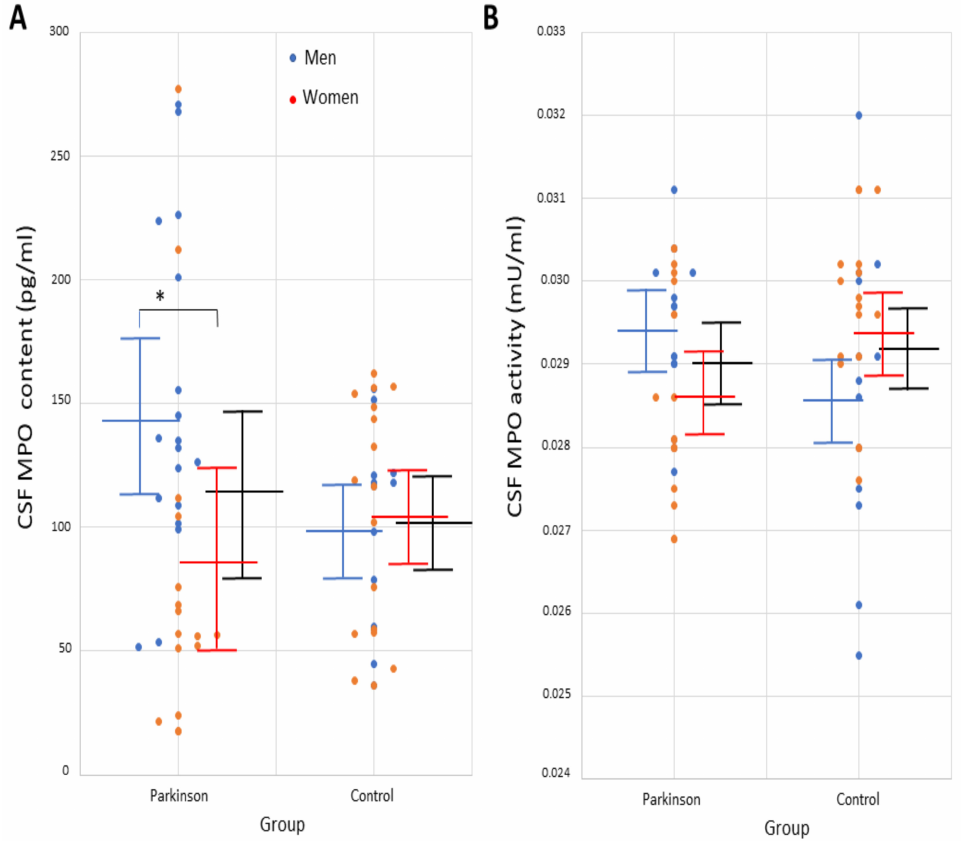
Figure 1. Individual values of ( A ) myeloperoxidase concentration (pg/mL) and ( B ) MPO activity (mU/mL) in the cerebrospinal fluid in male and female patients with idiopathic Parkinson’s disease and controls. Mean and standard deviation are represented with solid lines (black lines, cohort of patients and control participants; men are represented in blue and women in orange). * p < 0.01. Abbrev.: CSF, cerebrospinal fluid; MPO,